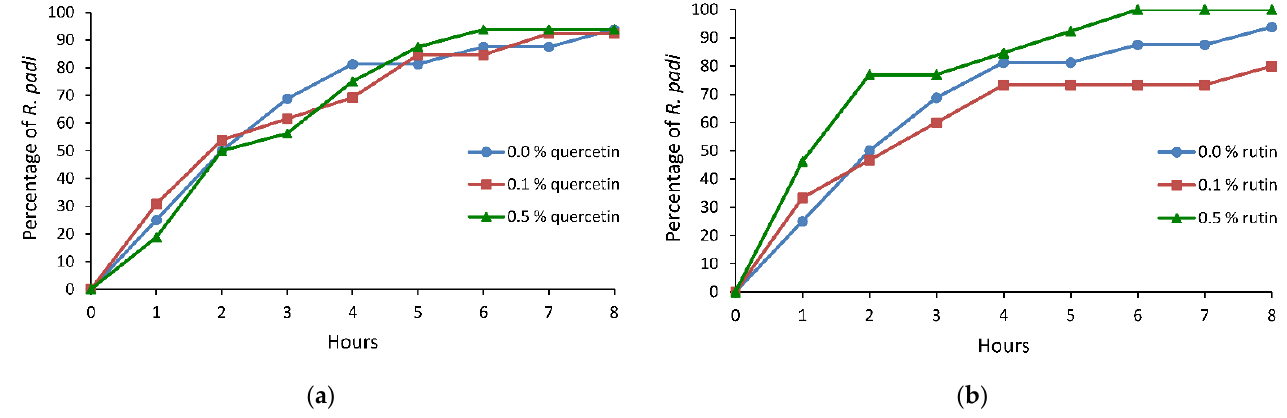
Figure 3. Cumulative proportion of Rhopalosiphum padi individuals that reached phloem sieve elements on Avena sativa treated with 0.0%, 0.1%, and 0.5% ethanolic solutions of ( a ) quercetin and ( b )